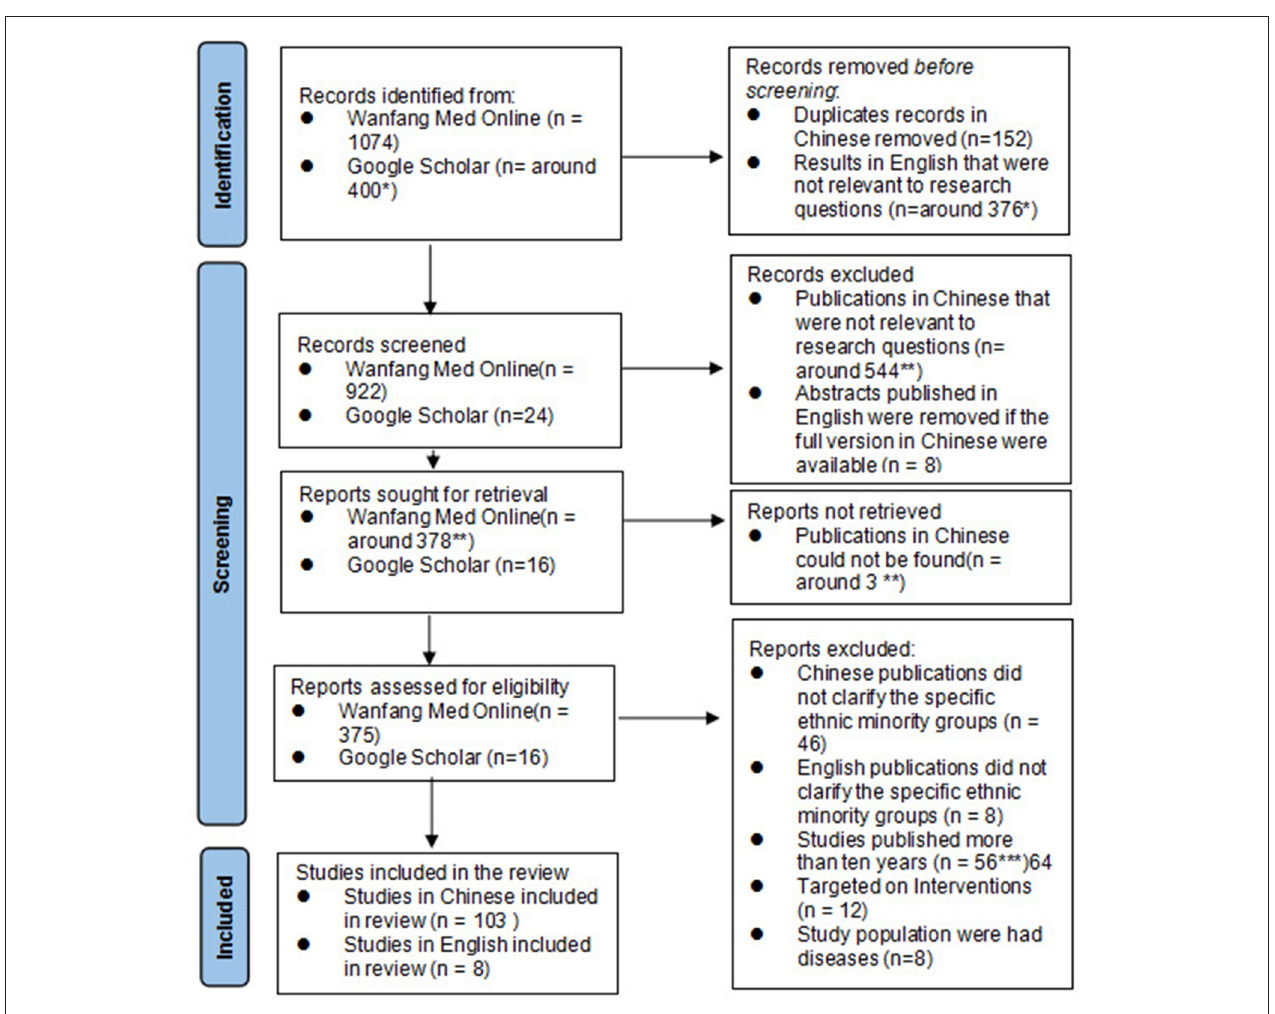
FIGURE 3 | The PRISMA flow diagram for the details of the literature selection process. *When using keywords searched in Google Scholar, there were more than 400,000 results in total. It was very difficult to identify them all. Because the following listed results were increasingly irrelevant to the beginning listed results, if there were continuously 100 results that were not relevant, the identification process will be terminated. Finally, around 400 results were identified by the first author. **The current review was edited based on a student course essay. The PRISMA flow diagram was provided during the submission review and formed based on research notes and memory. Thus, three numbers in the flow diagram were based on recall and may not be accurate, but it will not affect the literature review and the results. ***The total number of studies published more than 10 years was 64. However, eight of them were either related to the general trends of nutrition status and dietary practices in a specific period or the most recent publication for a specific ethnic minority group. Therefore, these eight publications were finally